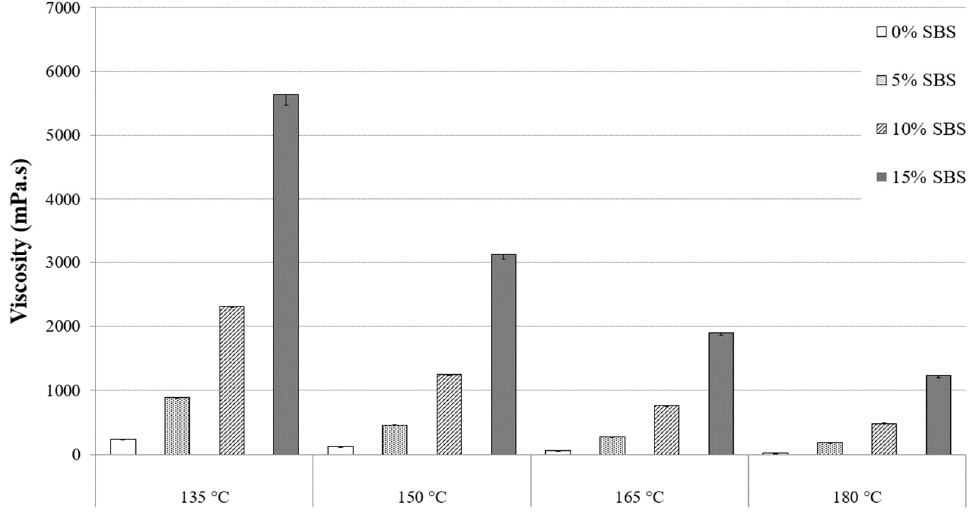
Figure 3. Viscosity of PG 64 ‐ 22 binder with 12% processed oil as a function of SBS content.